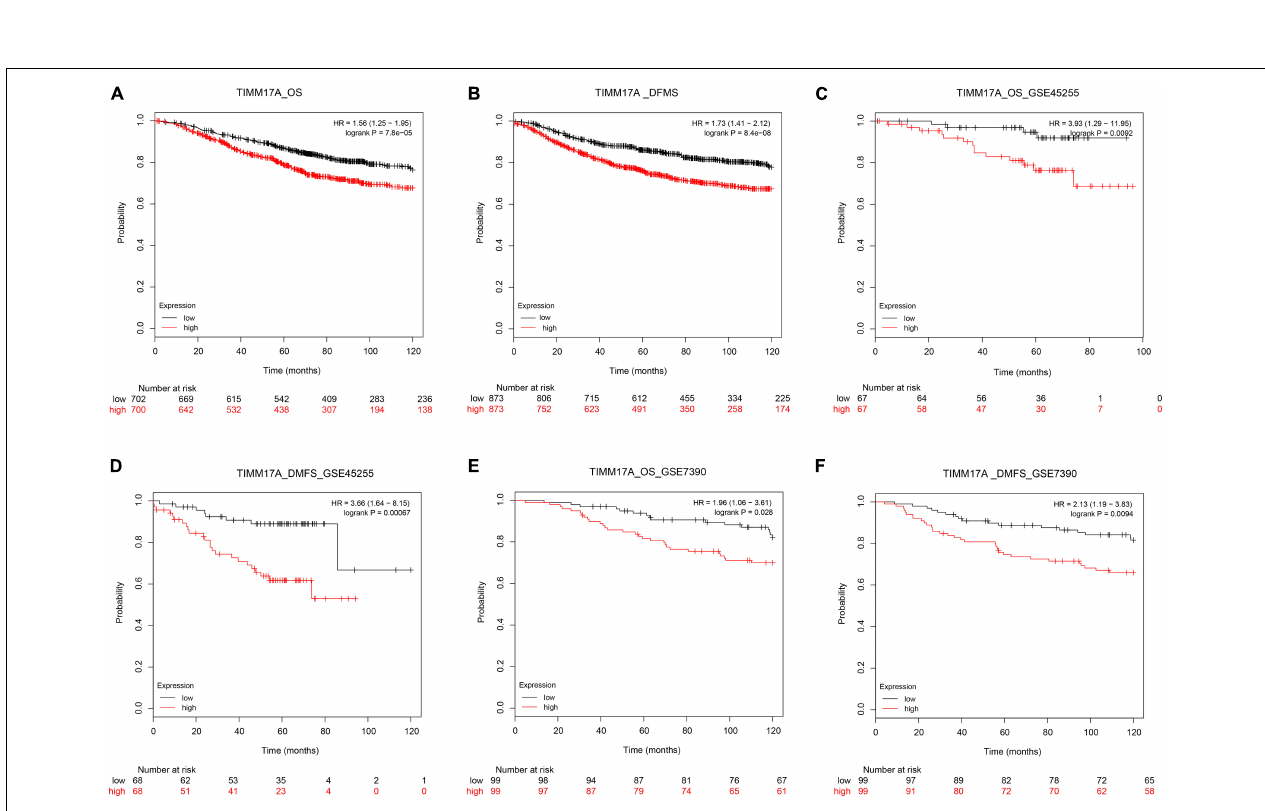
FIGURE 2 | Kaplan–Meier survival curves showing significantly reduced overall survival (OS) and shorter distant metastases-free survival (DMFS) among breast cancer patients with high levels of TIMM17A expression. Clinical survival outcomes of breast cancer patients with high or low expression levels of TIMM17A . (A) OS in TCGA cohorts. (B) DMFS in TCGA cohorts. (C) OS in the GSE45255 cohort. (D) DMFS in the GSE45255 cohort. (E) OS in the GSE7390 cohort. (F) DMFS in the GSE7390 cohort. Plots are truncated at 10 years.